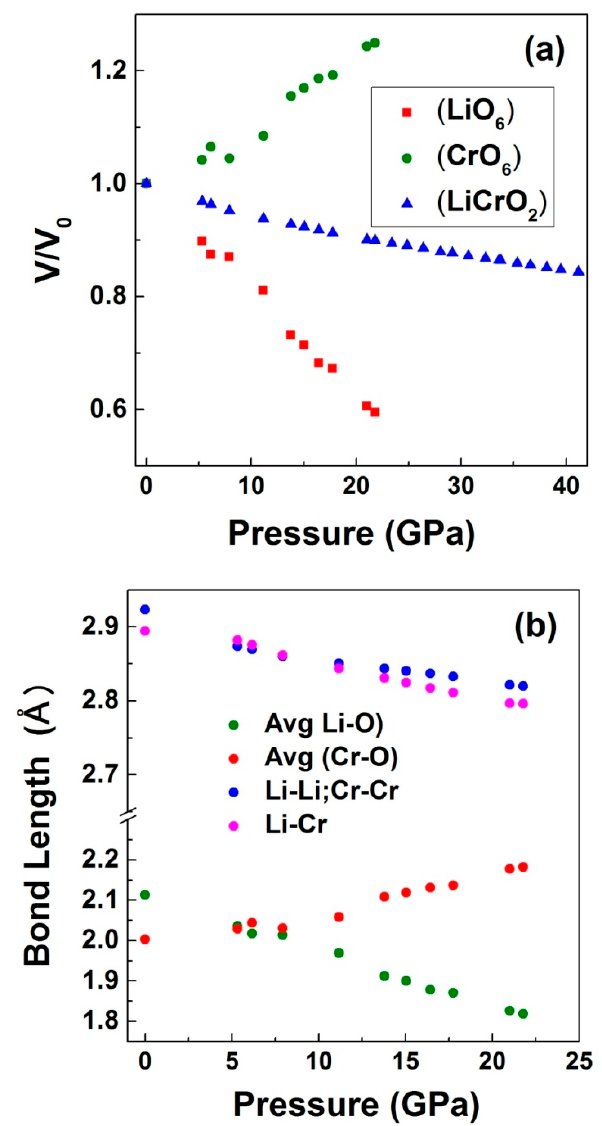
Figure 8. ( a ) Normalized volume of LiO 6 and CrO 6 octahedra along with the overall lattice volume . ( b ) Cation-cation and anion-cation bond lengths. Note that except for the Cr-O bond all other bonds shrink with